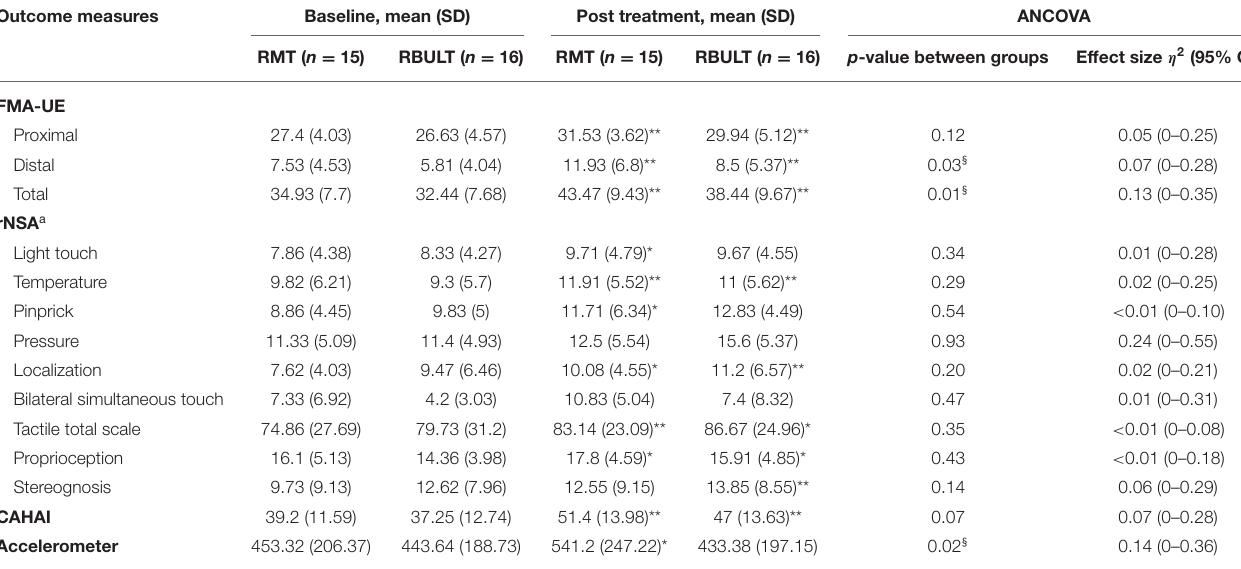
TABLE 2 | Descriptive and inferential statistics of the outcome measures at baseline and posttest per treatment group. Outcome